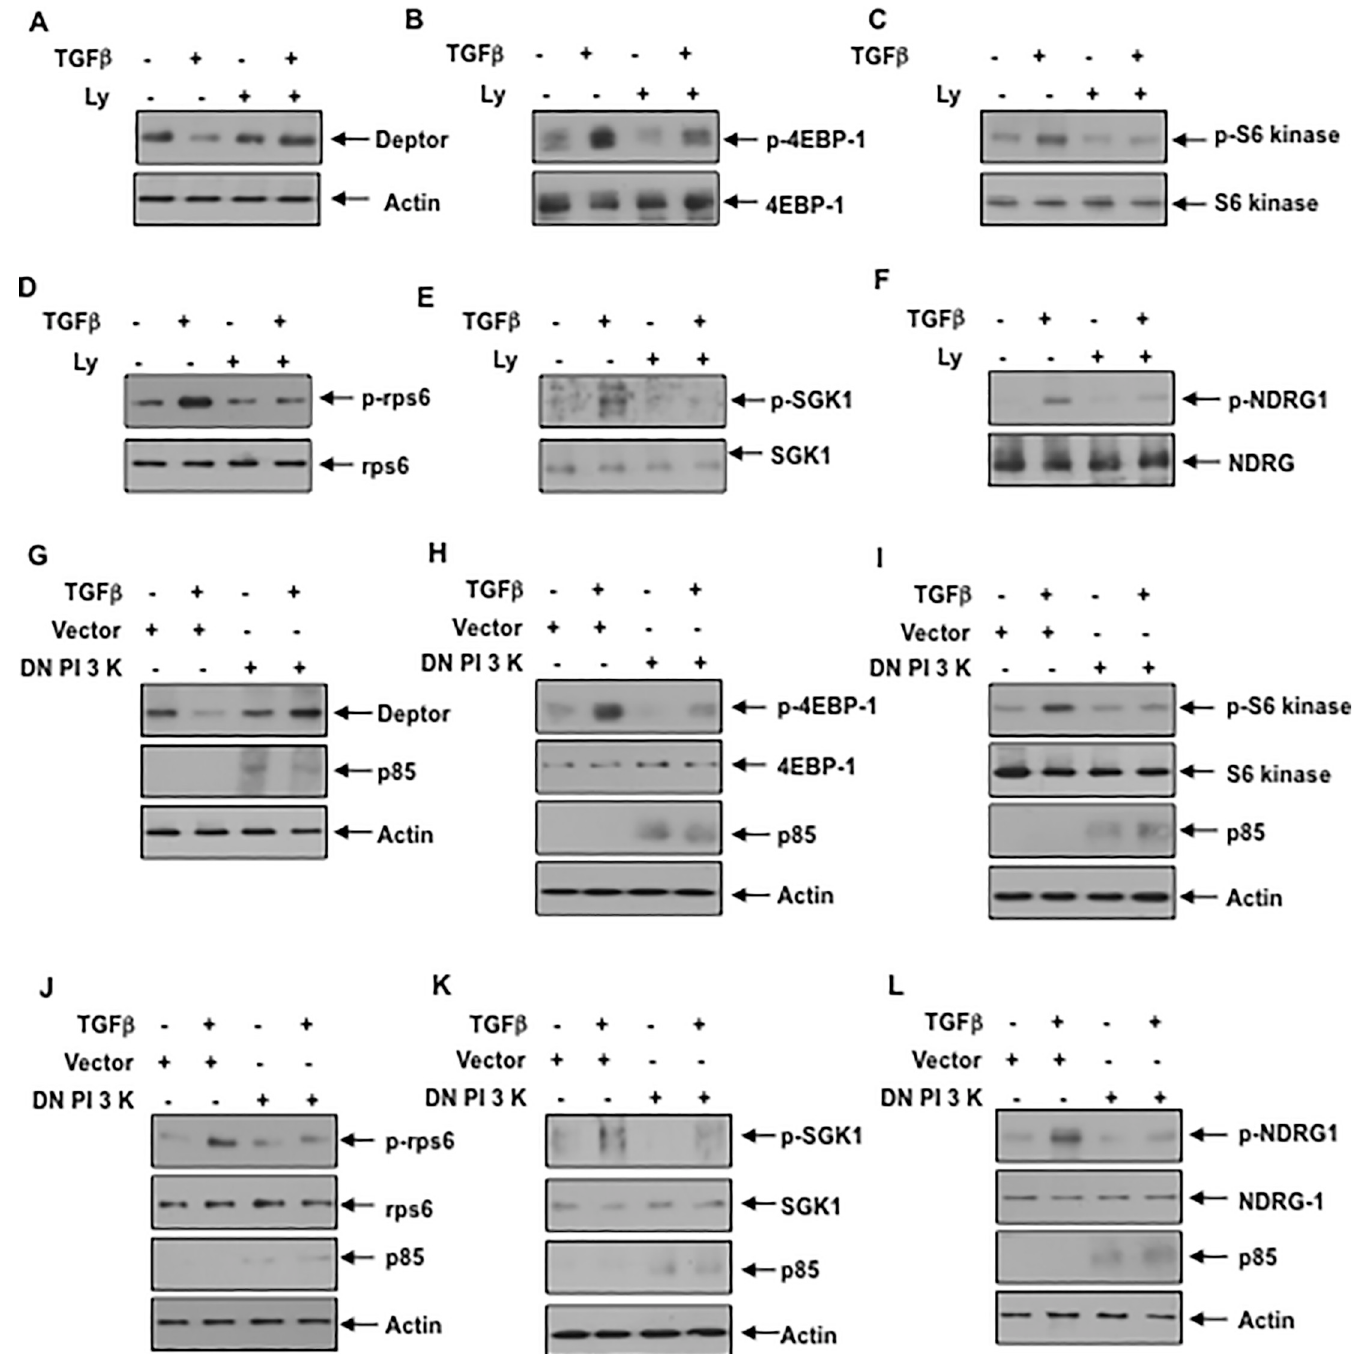
Fig 2. Inhibition of PI 3 kinase blocks TGF β induced deptor suppression and activation of mTORC1 and mTORC2. (A–F) Serum-starved podocytes were treated with 25 micromolar Ly for none hour prior to incubation with 2 ng/ml TGF β for 24 hours. The cell lysates were immunoblotted with the indicated antibodies. (G–L) Podocytes were transfected with the mutant p85 PI 3 kinase subunit as described in the Materials and Methods. The transfected cells were serum starved and incubated with TGF β as described above. The cell lysates were immunoblotted with the indicated antibodies. Representative blots from four independent experiments are shown in each panel. The quantification is shown in the S3 Fig.